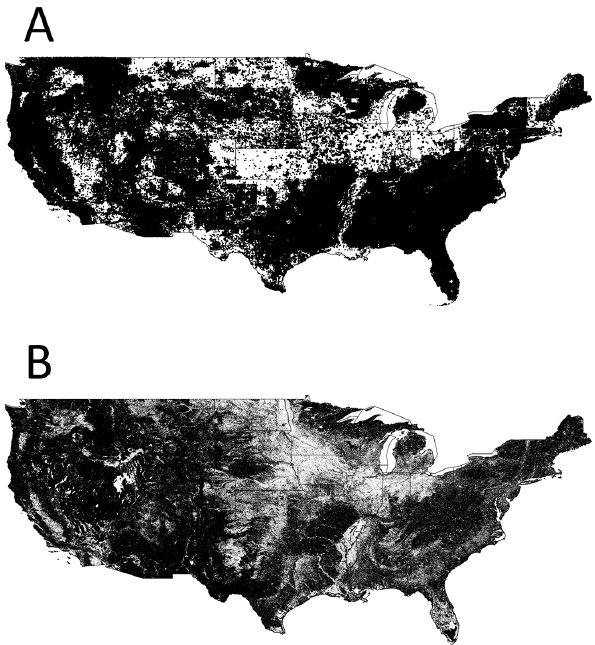
Figure 2. Locations of (A) all wildfire records in the conterminous US included in the FPA FOD, 1992–2011, and (B) land mapped as burnable wildland surface-fuel types in the 30 m resolution LAND- FIRE Refresh 2008 data set (LF_1.1.0b; see Ryan and Opperman, 2013). Points depicting the locations of fires are not to scale. Areas with few or no fires represented in the data set may have a ff orded lit- tle viable data for inclusion in the FPA FOD, or, alternatively, may be areas with little or no burnable land cover. Non-burnable fuel types are those with “insu ffi cient wildland fuel to carry wildland fire under any condition”, and include urban or suburban development, agricultural land maintained in a non-burnable condition, snow / ice, open water, and bare ground (Scott and Burgan, 2005).